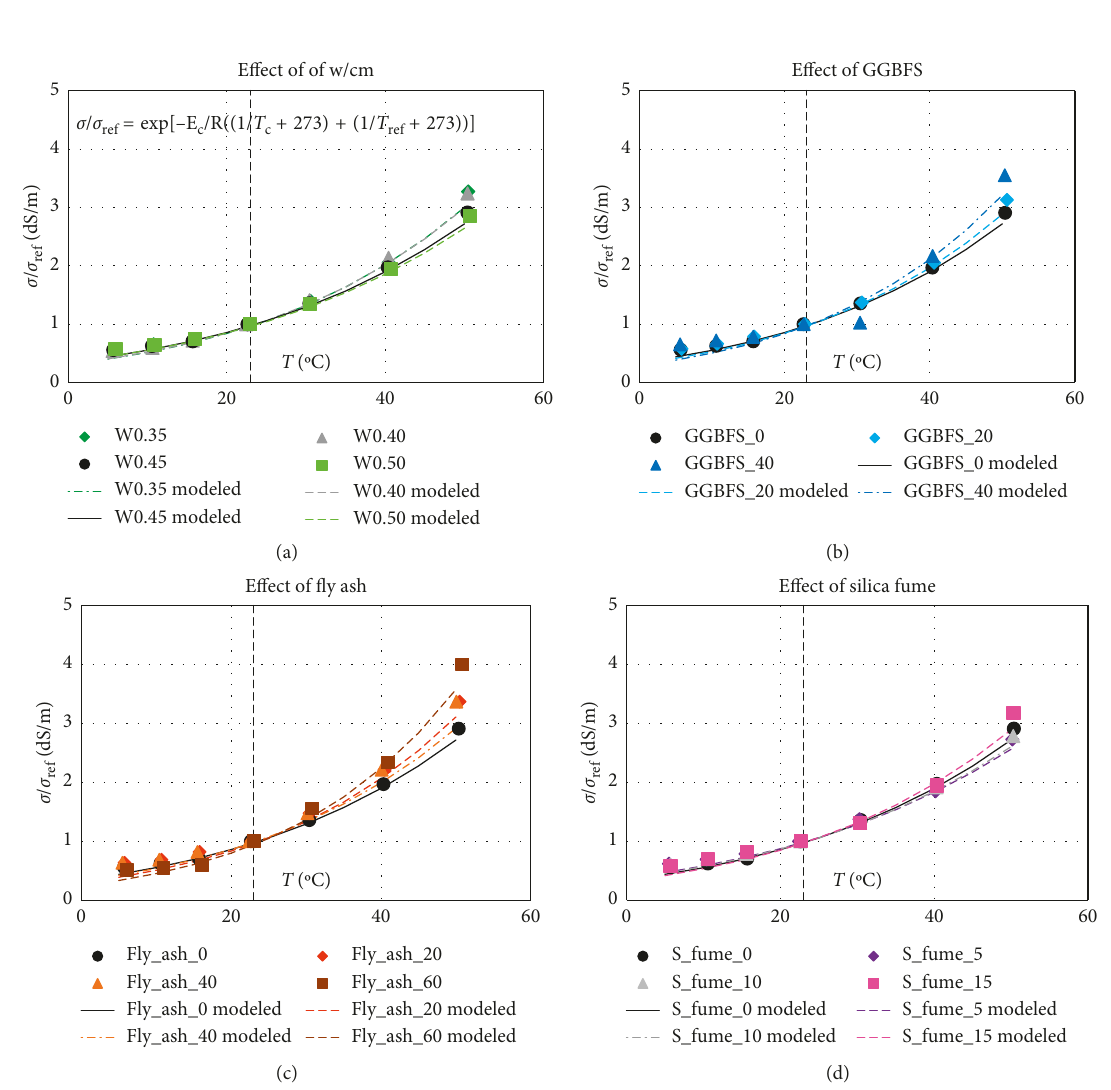
Figure 5: Experimental and modeled σ/σ 23 ° C. (cid:31)